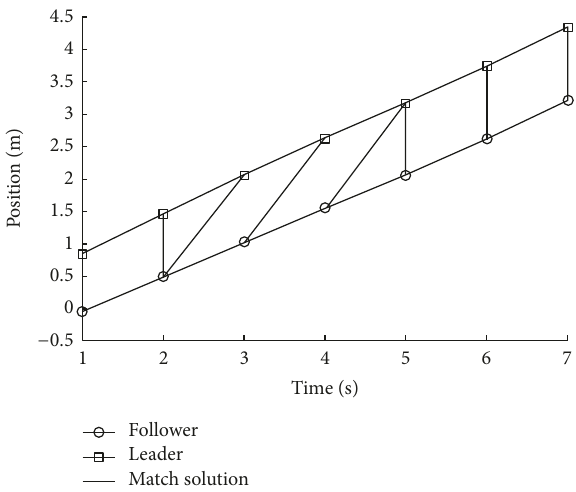
Figure 1: Pedestrian trajectories with DTW match